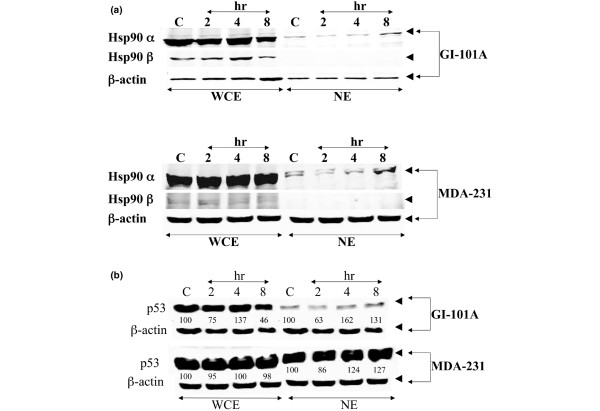
Western blots of heat shock protein 90 (Hsp90) proteins from control and PRIMA-1-treated cells. Cells were treated with 100 μM PRIMA-1 for 2, 4 or 8 hours. 20 μg of protein samples of cell lysates from the whole cell extracts (WCE) and nuclear extracts (NE) of the control (C) and treated samples were separated by SDS-PAGE (4 to 20% polyacrylamide) and Western blotted with antibodies directed against both the α and β isoforms of Hsp90 (a) and against p53 (b). β-Actin was used as a loading control. The reactive bands were detected with the Odyssey™ Infrared Imaging System.